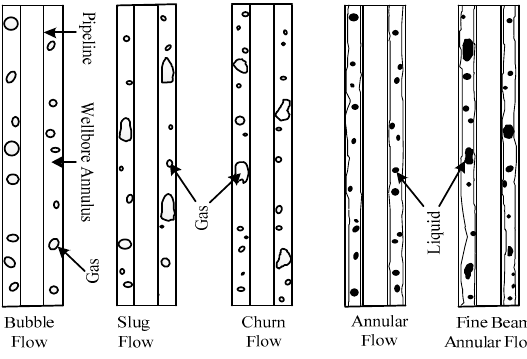
Figure 6. Pattern graph of two-phase flows in vertical ascending pipelines.